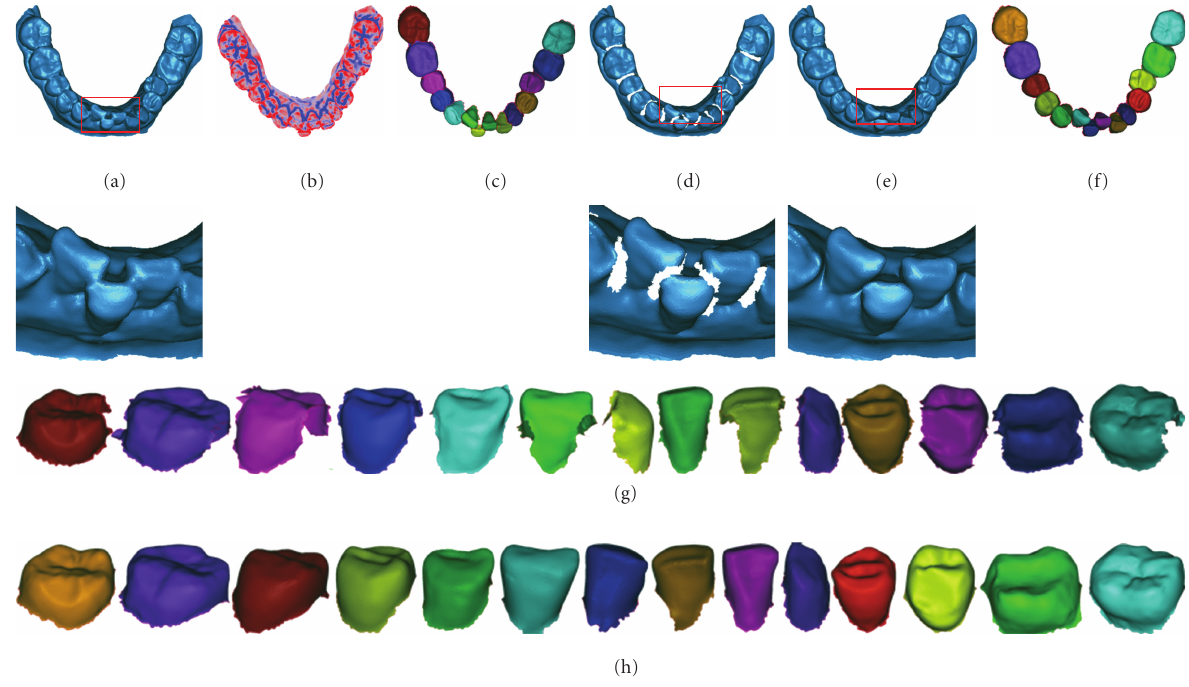
Figure 17: Single-tooth Modeling results of 3D dental model with severe malocclusion. (a)The initial 3D dental model. (b) Minimum curvature color map. (c) Separation results shown as a whole corresponding to the initial 3D dental model. (d) After the fusion regions being deleted. (e) After single-tooth shape being restored. (f) Separation results corresponding to the 3D dental model after shape restoration. (g) The separated tooth in (c) displayed, respectively. (h) The separated tooth in (f) displayed,